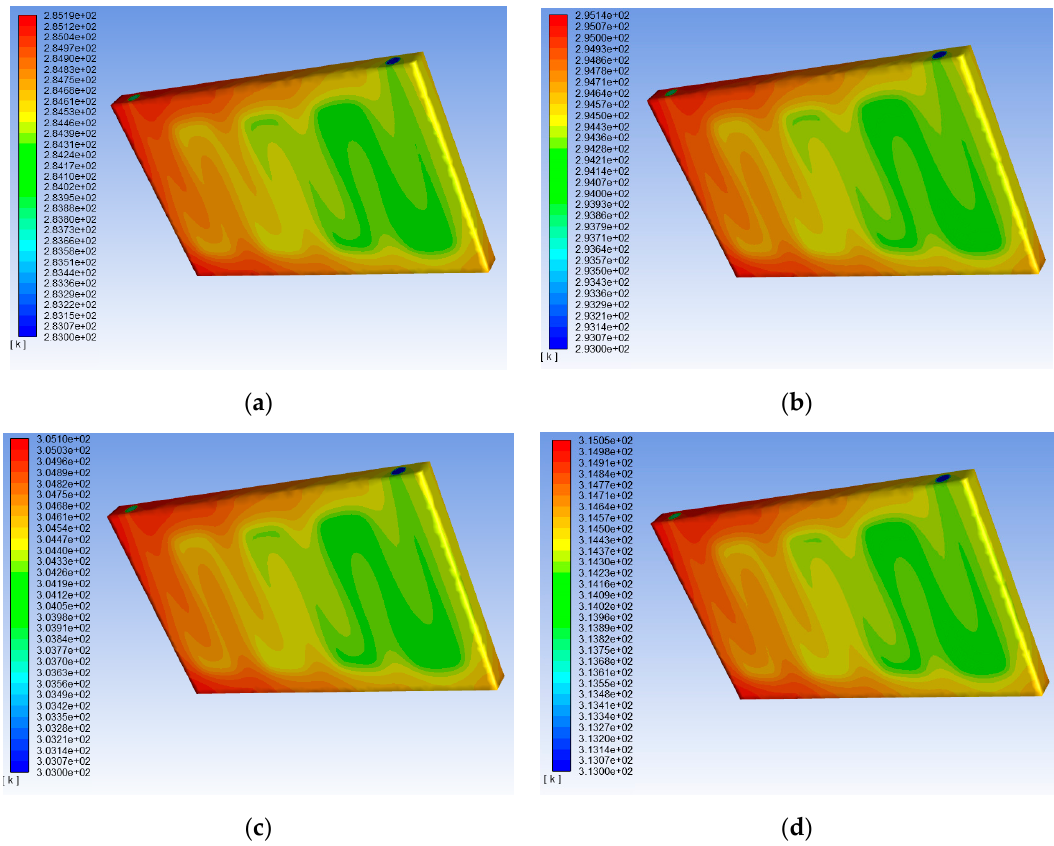
Figure 6. The temperature profile for different entrance temperatures of coolant fluid: ( a ) 283 K, ( b ) 293 K, ( c ) 303 K, ( d ) 313 K. Batteries 2020 , 6 , x FOR PEER REVIEW